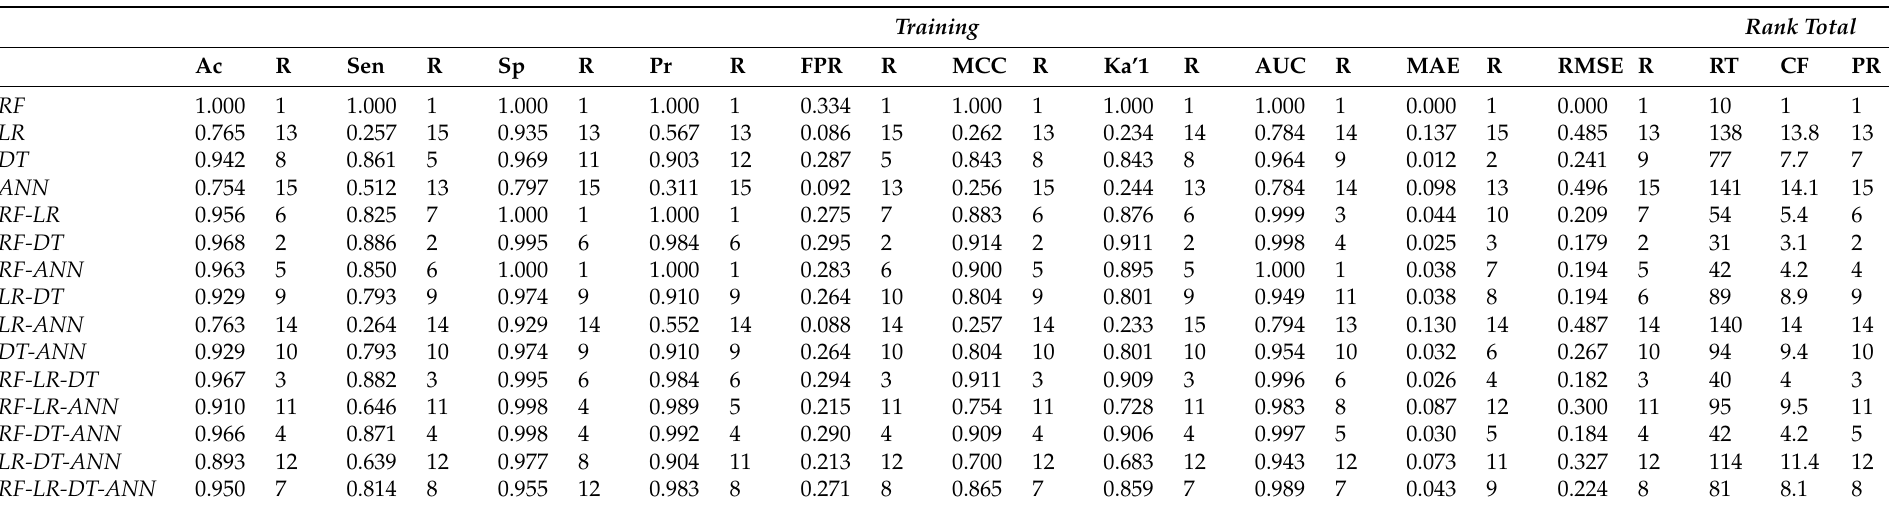
Table 5. Results of validation techniques and accuracy prioritization based on training